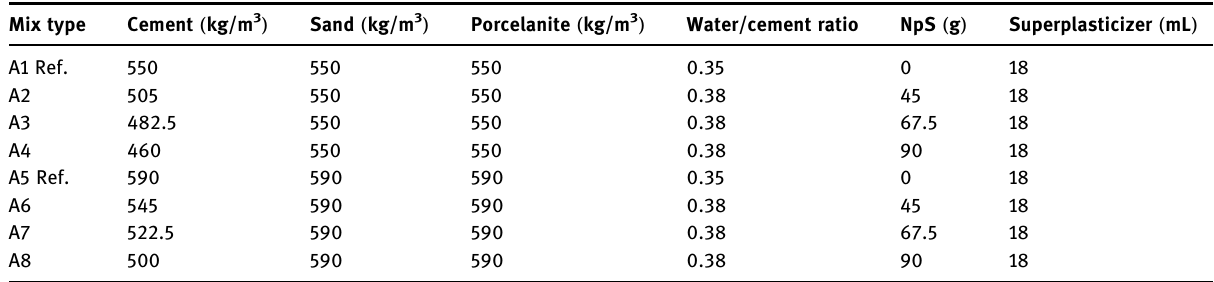
Table 4: The mix proportion of specimen Mix